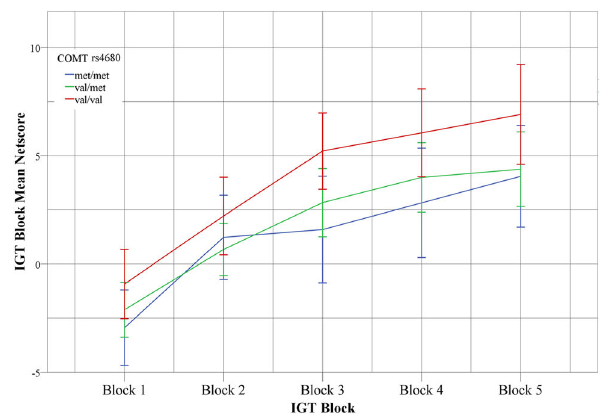
Figure 2. IGT Netscores along the five test blocks for COMT val158met groups.